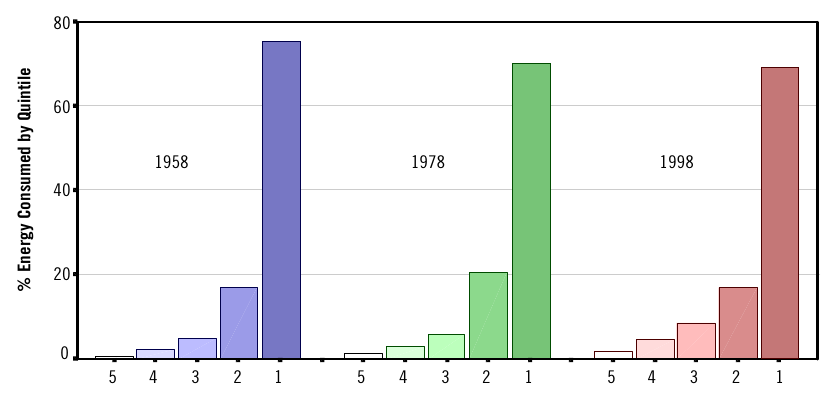
Figure 6 – World Commercial Energy Consumption by